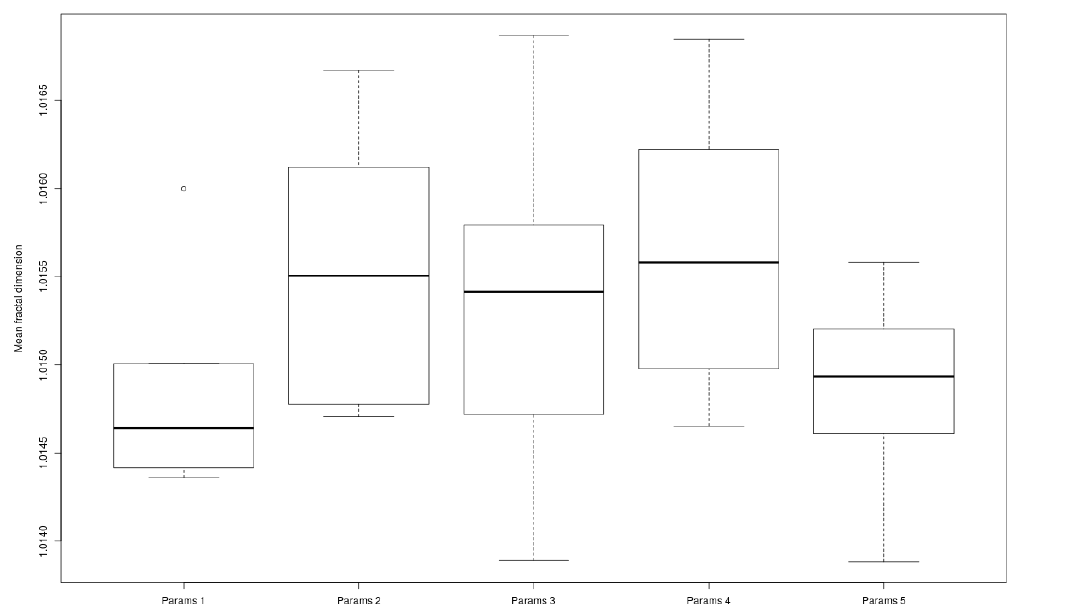
Figure C1. Mean fractal dimension in each of the five behavioural parameter sets (parameters 1–5) measuring the fragmentation of land uses in